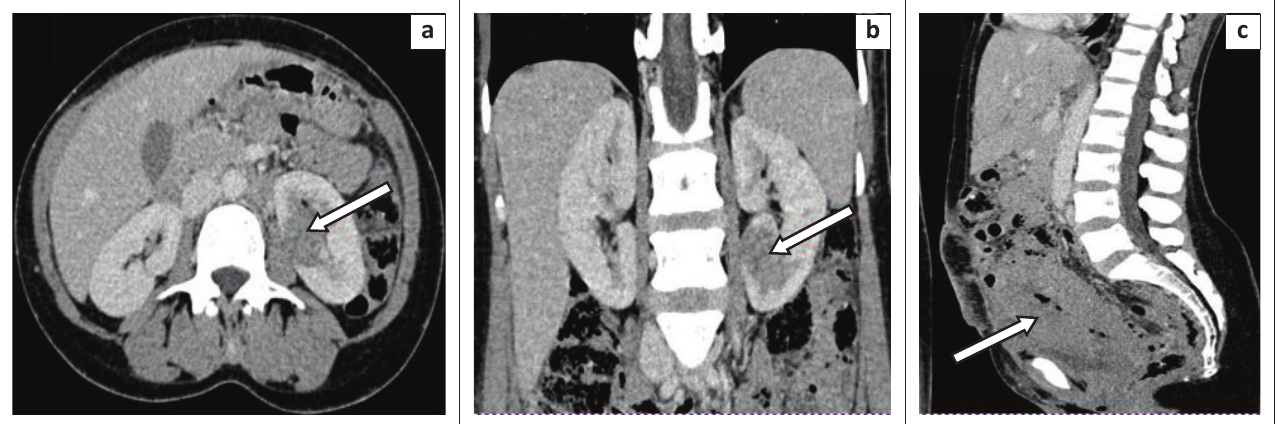
FIGURE 3: Incidental finding of renal cell carcinoma (RCC) on a post-caesarean section ultrasound. Contrast-enhanced portovenous phase computed tomography images show: (a) an ill-defined hypoenhancing mass lesion in the left renal cortex (arrow) with a poor plane of separation between the mass and the psoas muscle, concerning for extra-renal extension. (b) Coronal image demonstrates that the mass arises in the lower pole of the left kidney. (c) Sagittal image demonstrates post-partum changes with an enlarged uterus as well as a thickened uterine wall and air within the uterine cavity (arrow). A diagnosis of clear cell RCC was confirmed at